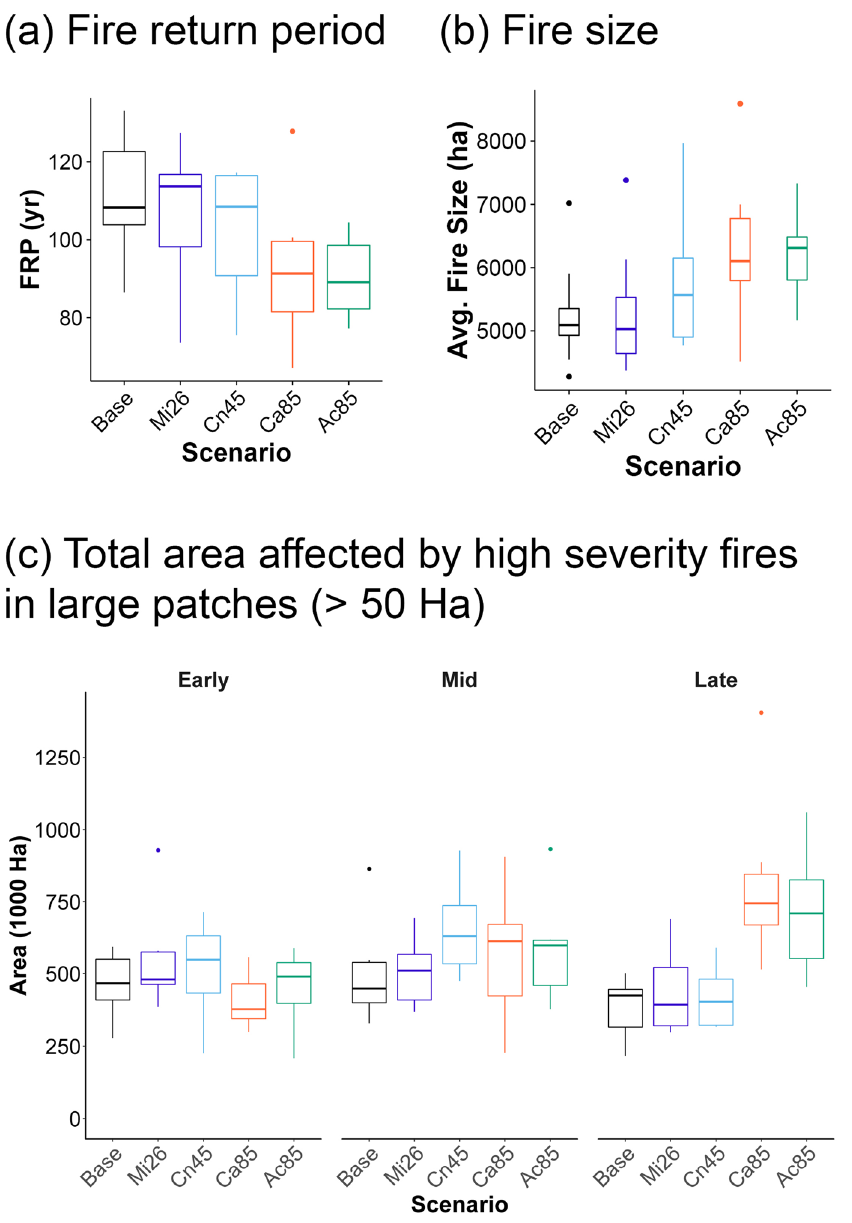
Figure 3. Fire regime model outputs. ( a ) Fire return period – time to burn an area of the same size of the area of study; ( b ) Average fire size for different simulation repetitions under baseline and climate change scenarios; ( c ) Total area of high severity fire for different scenarios; ( d ) High severity area change for large fire patches ( > 50 ha). Boxplot represents different the distribution of values across 9 simulation repetitions. See Table 1 for climate change scenario